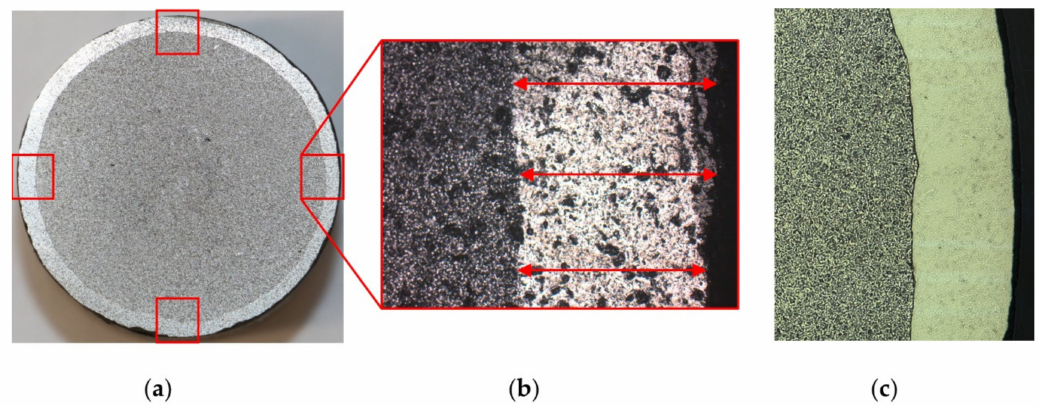
Figure 12. ( a ) Laser cladded coating after CWR, grinding and sandblasting with measuring points; ( b ) Picture of the coating after CWR taken by the microscopes camera; ( c ) Polished surface of the cut. Just like in the simulation, the coating thickness varies most between the two di ff erent cross-section reductions. At a reduction of ∆ A = 20% the average coating thickness is s = 1.34 mm while it amounts to s = 0.84 mm for a cross-section reduction ∆ A = 70%. As already described, this can be explained